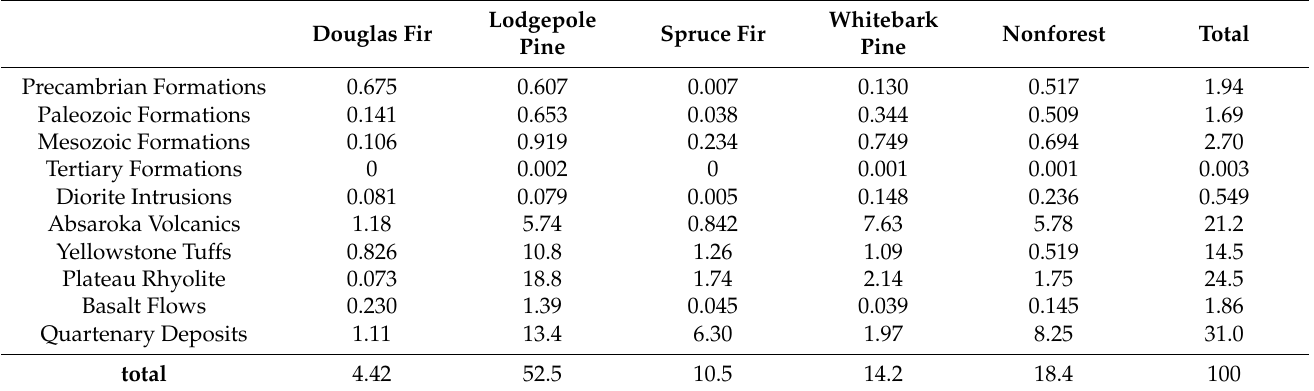
Table 5. Estimated area cover % of the lithology–vegetation